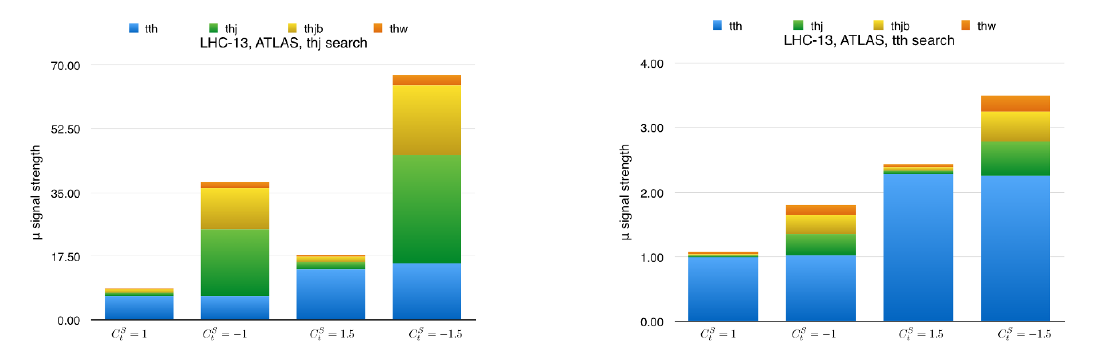
Figure 10 . Accumulated signal strengths (cid:22) ( thj ) (left) and (cid:22) ( t (cid:22) th ) (right) at LHC-13 obtained by stacking the various thX contributions on the t (cid:22) th one for C S right. We use the Delphes ATLAS template for detector